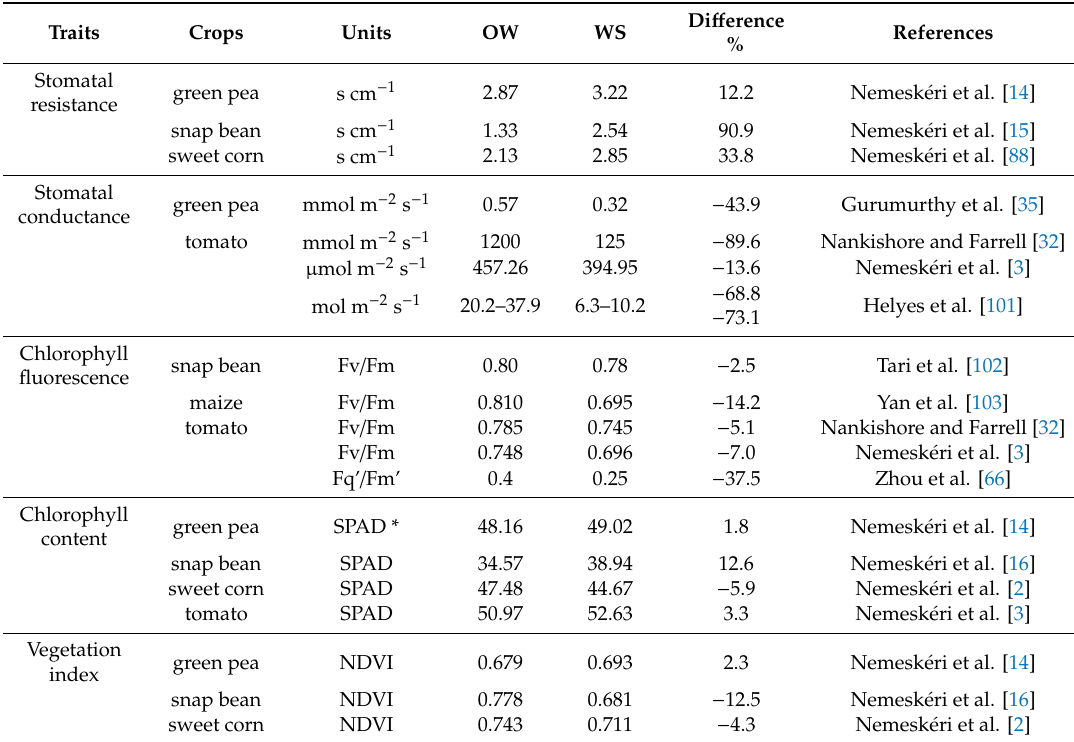
Table 3. Physiological traits related to water use and photosynthesis for vegetable crops under optimal water supply (OW) and water stress (WS)